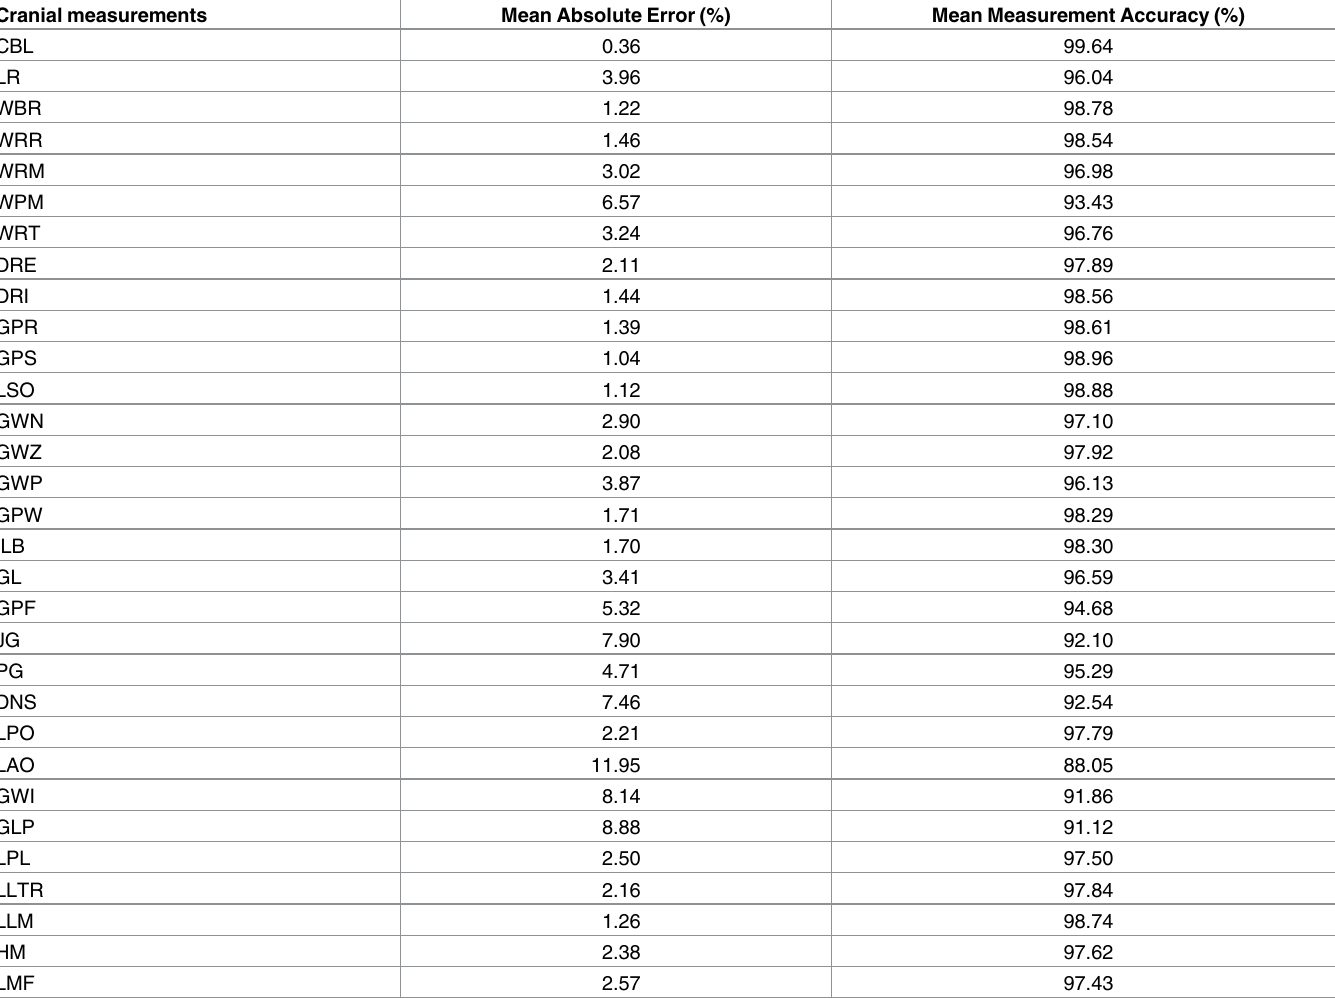
For abbreviations, refer to Table